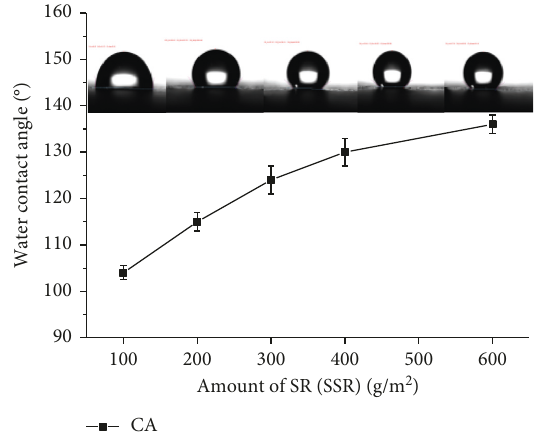
Figure 10: Static contact angles of